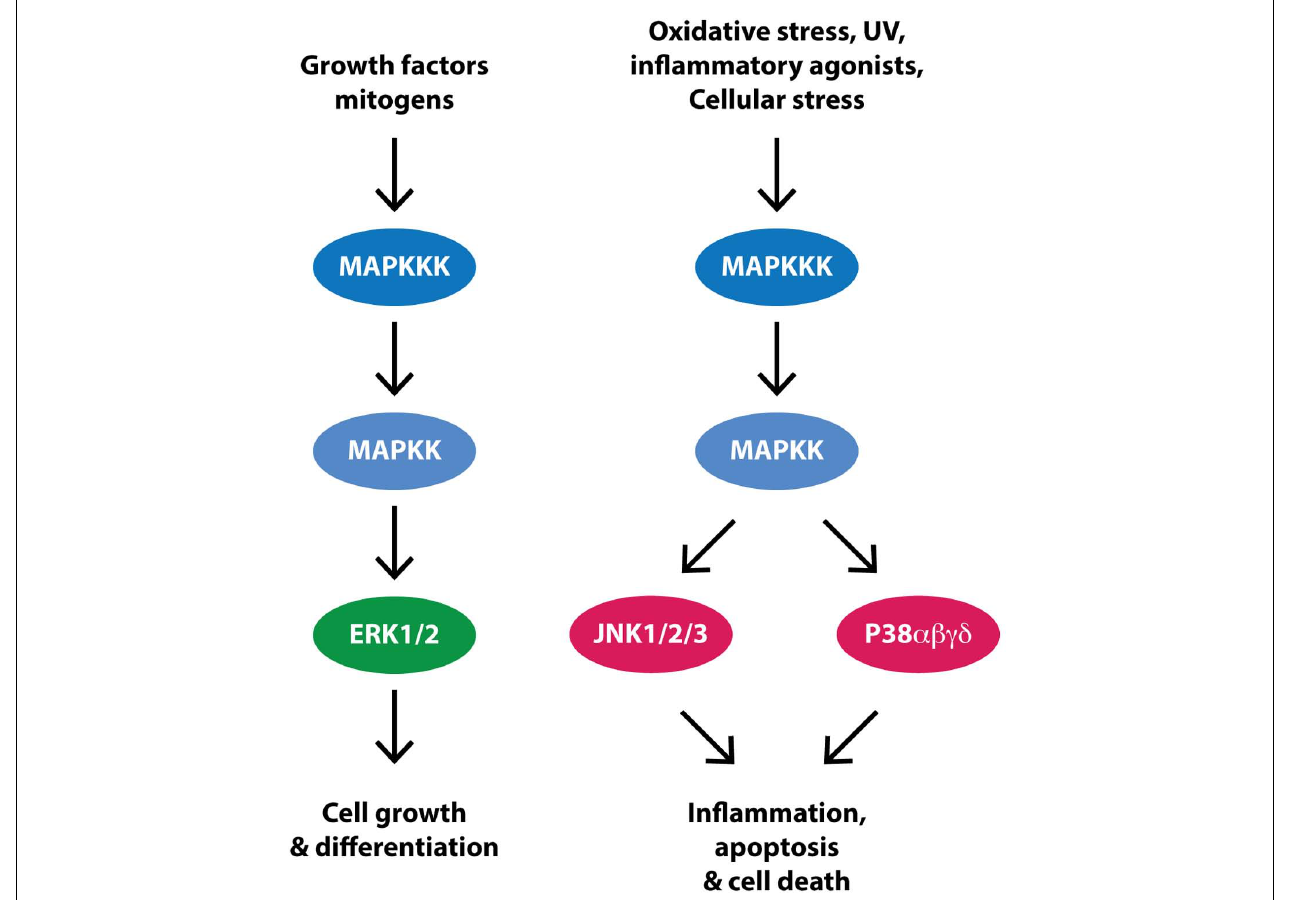
FIGURE 2 | Simplifed MAPK signaling. Receptor activation by growth factors or mitogens triggers a signal cascade in which mitogen activated protein kinase kinase kinases (MAPKKK) are activated and in turn activate mitogen activated kinase kinases (MAPKK) and then